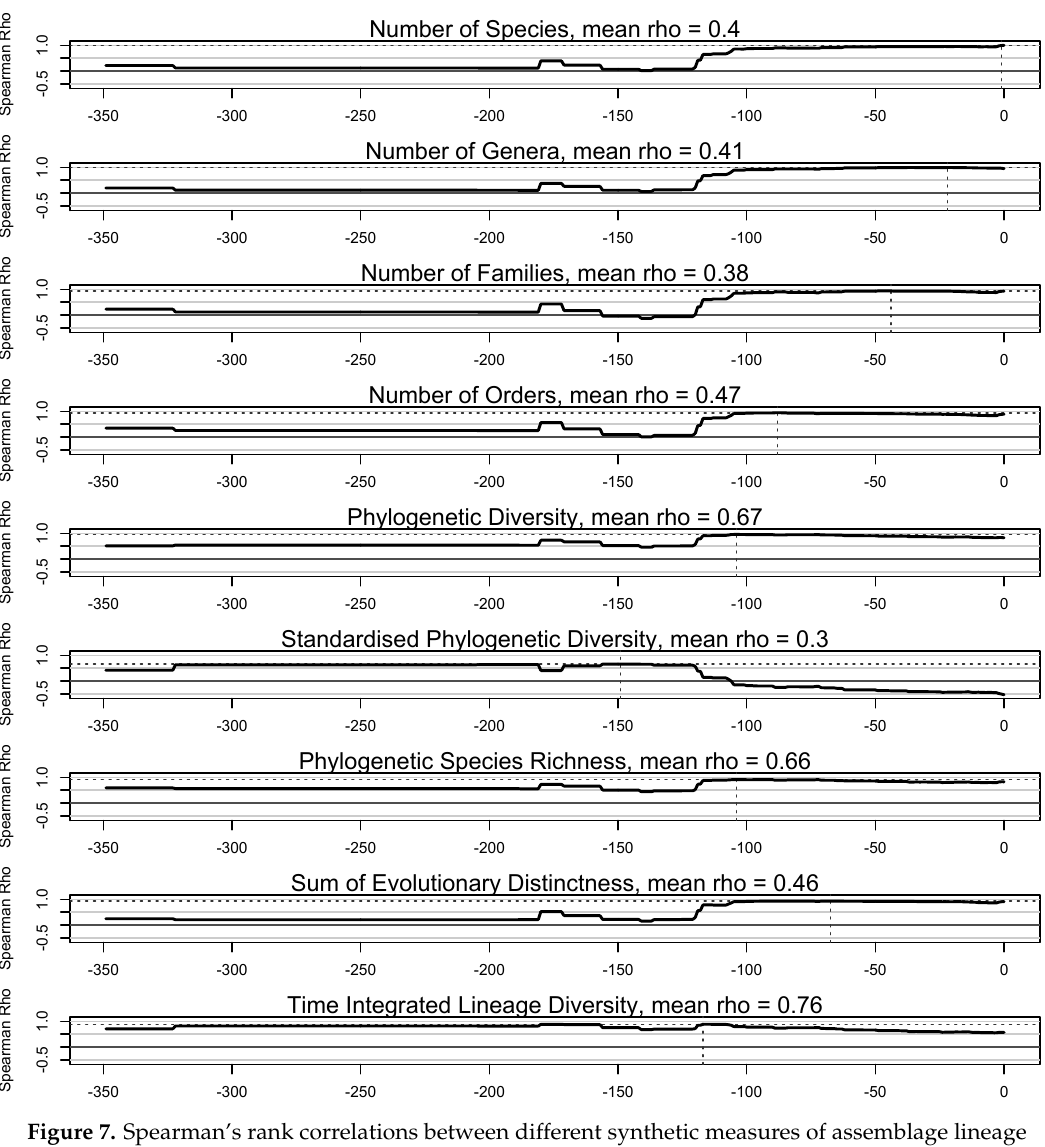
Figure 7. Spearman’s rank correlations between different synthetic measures of assemblage lineage diversity and the number of lineages at different phylogenetic depths. The mean value of spearman’s rho across all depths (excluding t = 0 and 350) is given above each plot. The phylogenetic depth at which the maximum correlation is found is marked with dashed lines going to the x and